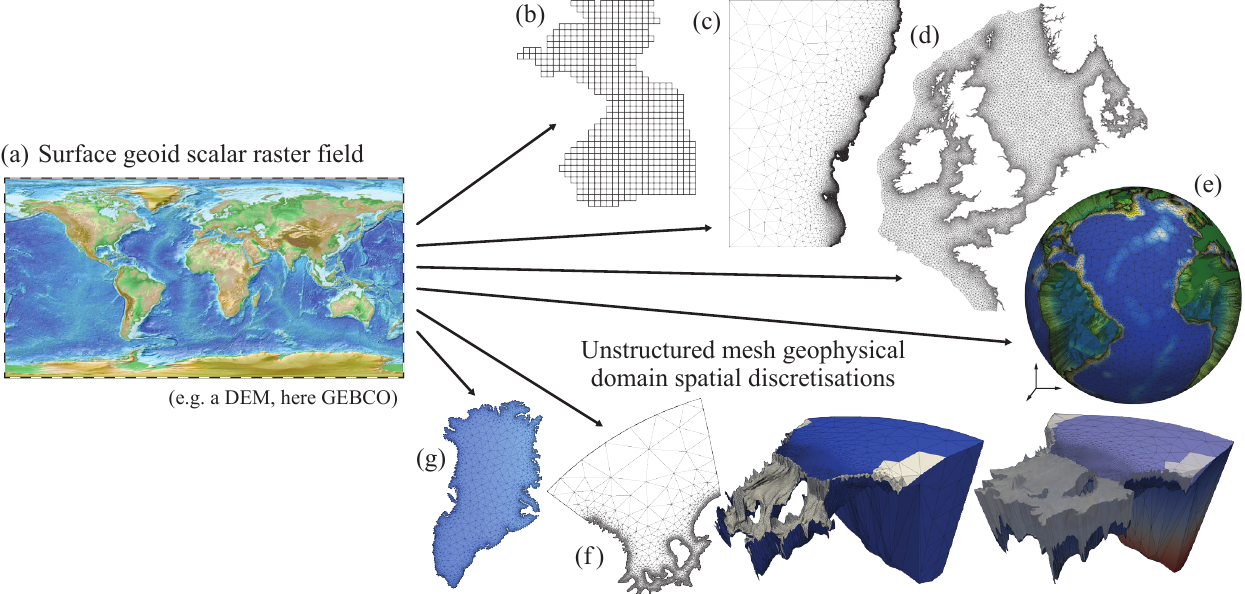
Figure 1. The challenge: to generate a self-consistent domain discretisation approach for geophysical domains that is generalised such that it can be applied to a wide range of applications, with new domains efficiently prototyped and iterated on, and is fully described such that the process can be automated, is reproducible, and is easily shared. (a) shows a typical source digital elevation map (DEM) dataset (that naturally lends itself to structured grid generation) used to produce a regular grid of the Atlantic Ocean (e.g. under a format-native land mask) in (b) , and the following selection of unstructured mesh spatial discretisations. (c) Bounded by part of the Chilean coastline and a meridian. (d) North Sea. (e) Global oceans. (f) Grounding line of the Filchner–Ronne ice shelf ocean cavity up to the 65 ◦ S parallel, with surface geoid mesh T h , full mesh T with ice–ocean melt interface highlighted, and accompanied by ice sheet full discretisation. (g) Greenland ice